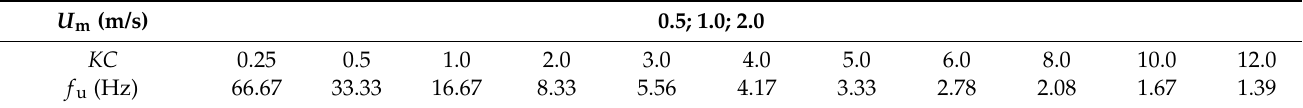
Table 2. Details of the numerical cases in the sinusoidal oscillating flow.